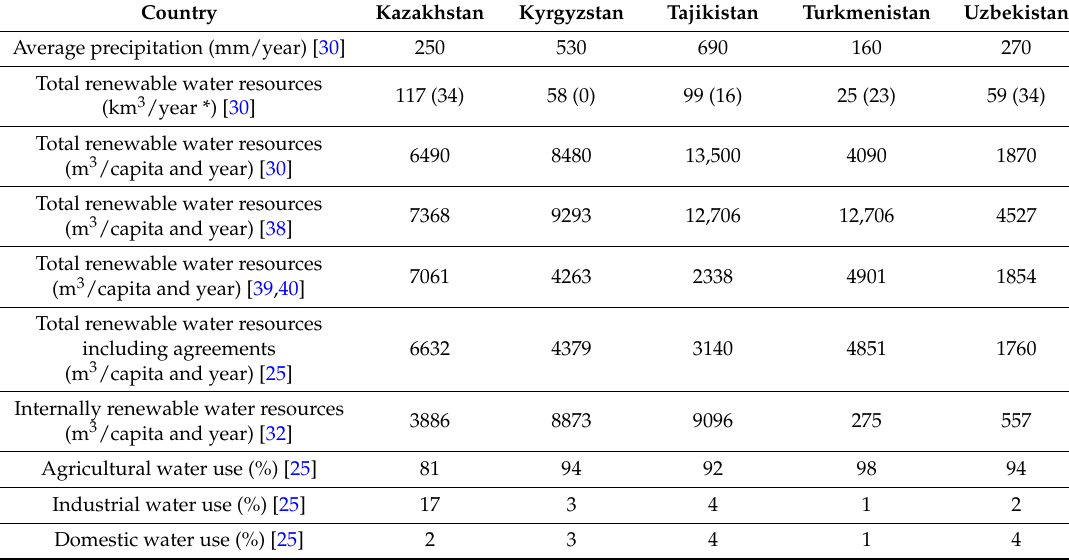
Table 1. Water use and renewable surface and groundwater resources of Central Asia. Country Kazakhstan Kyrgyzstan Tajikistan Turkmenistan